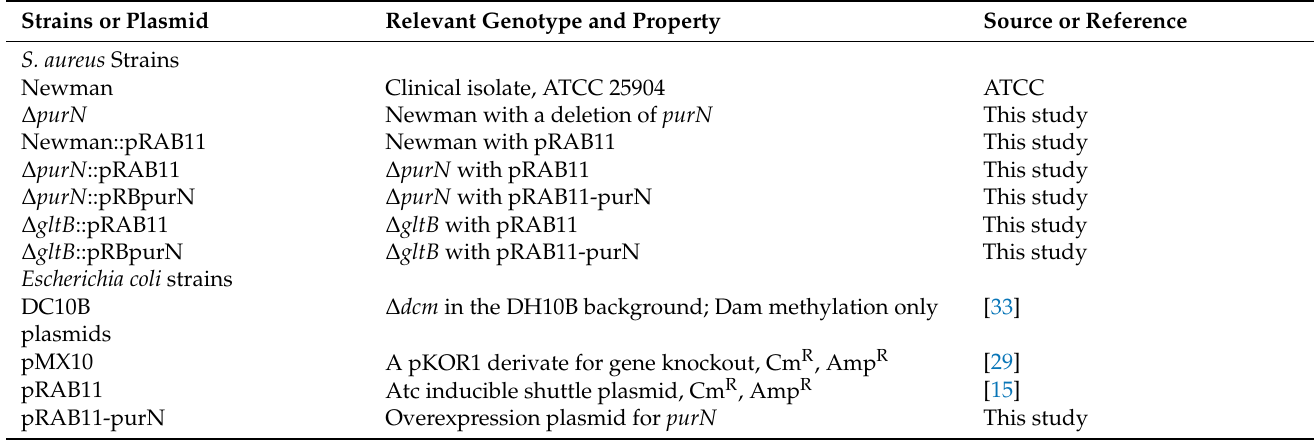
Table 1. Bacteria and plasmids used in this